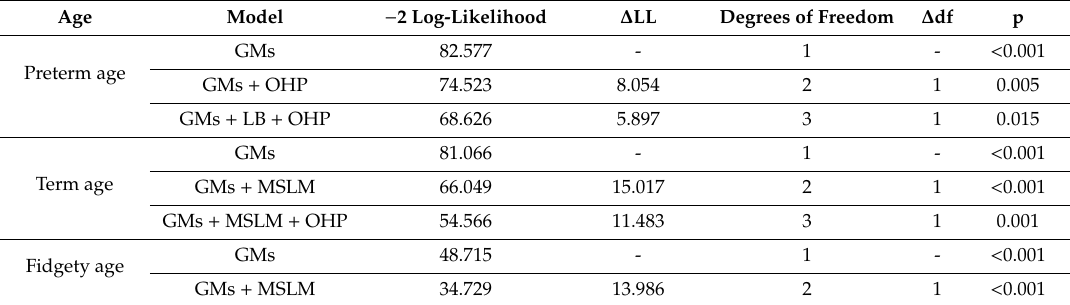
Table A2. Statistical characteristics of models used to identify sets of concomitant motor and postural patterns that along with GMs are mostly associated with cerebral